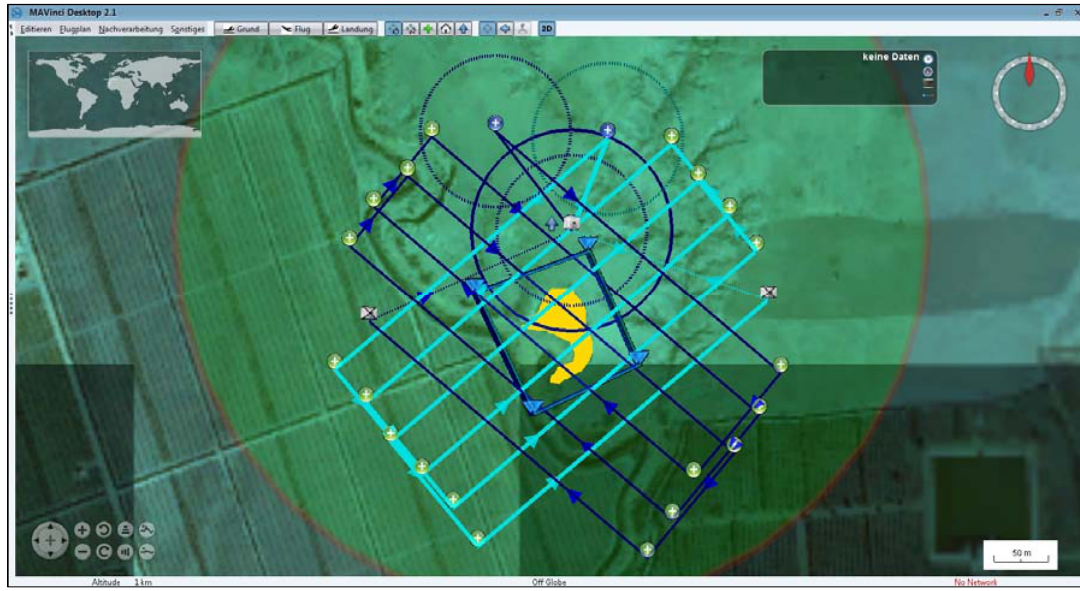
Figure 6. Flight plan for a small study site (HAM3, 85 m flying height). The variably shaded blue lines are two consecutive flight plans that are offset and rotated against each other to enable complete coverage of the small